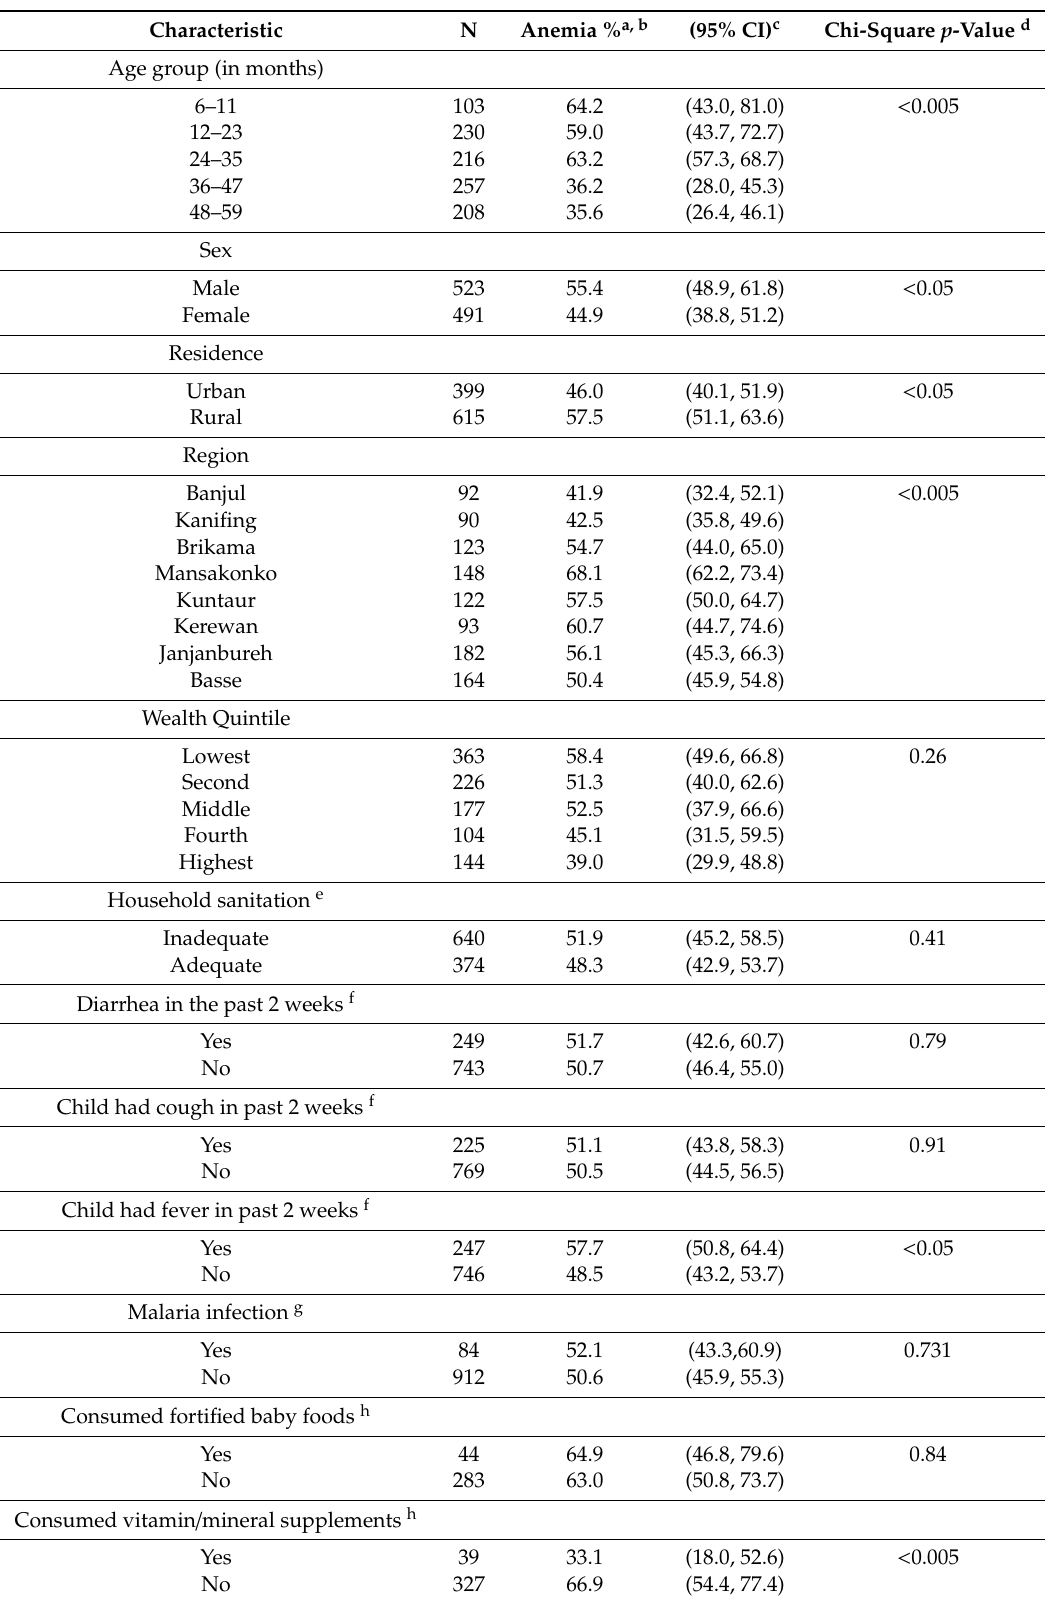
Table 2. Bivariate associations between anemia in children 6–59 months of age and demographics, nutritional status indicators, and